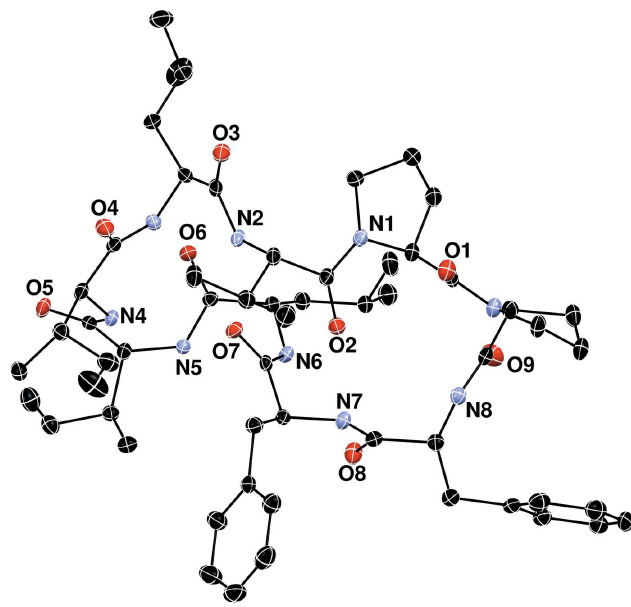
Figure 1 The molecular structure of the title compound. Displacement ellipsoids are drawn at 50% probability level. The DMSO solvent molecule is not shown.